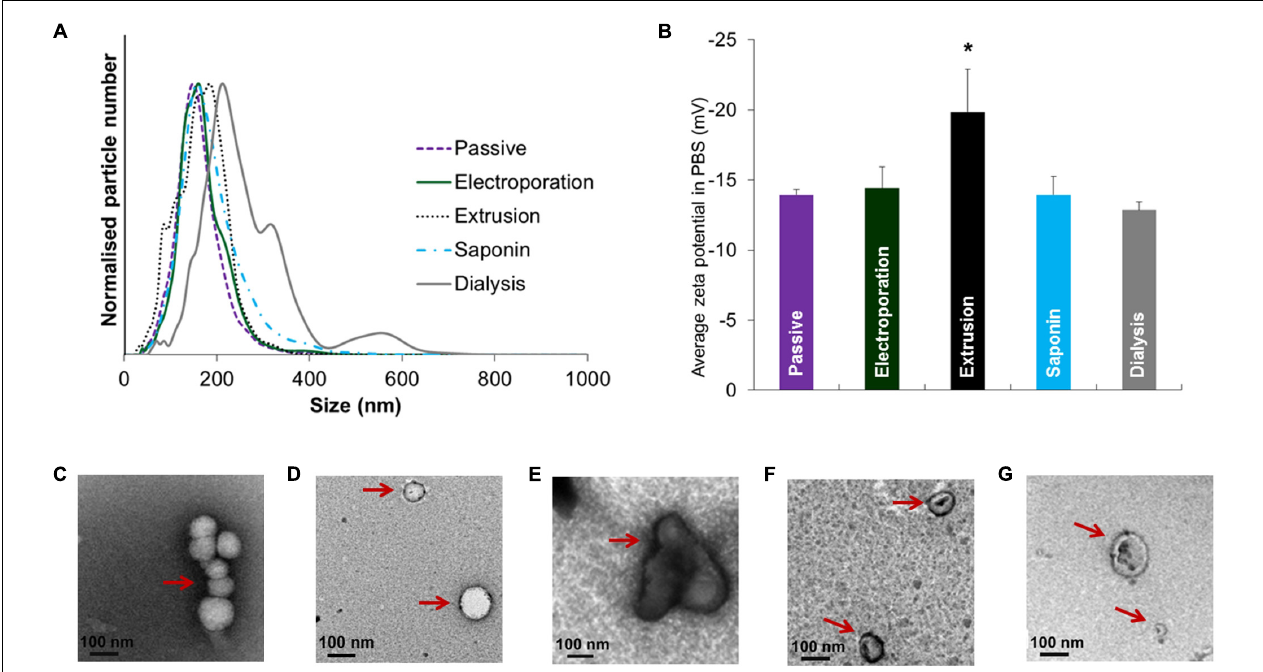
FIGURE 5 | Size distribution, zeta potential and morphology of EVs after drug loading with various methods. (A) Size distribution and (B) zeta potential after loading of porBA into vesicles from MDAs. Transmission electron microscopy images of EVs from MDAs indicated that shape and size of EVs after (C) passive, (D) electroporation, and (F) saponin treatment are not altered (arrows). While (E) extrusion, and (G) hypotonic dialysis induced aggregate formation and broader size range of EVs, respectively (arrows) (* p < 0.05). Figure reprinted from Fuhrmann et al.